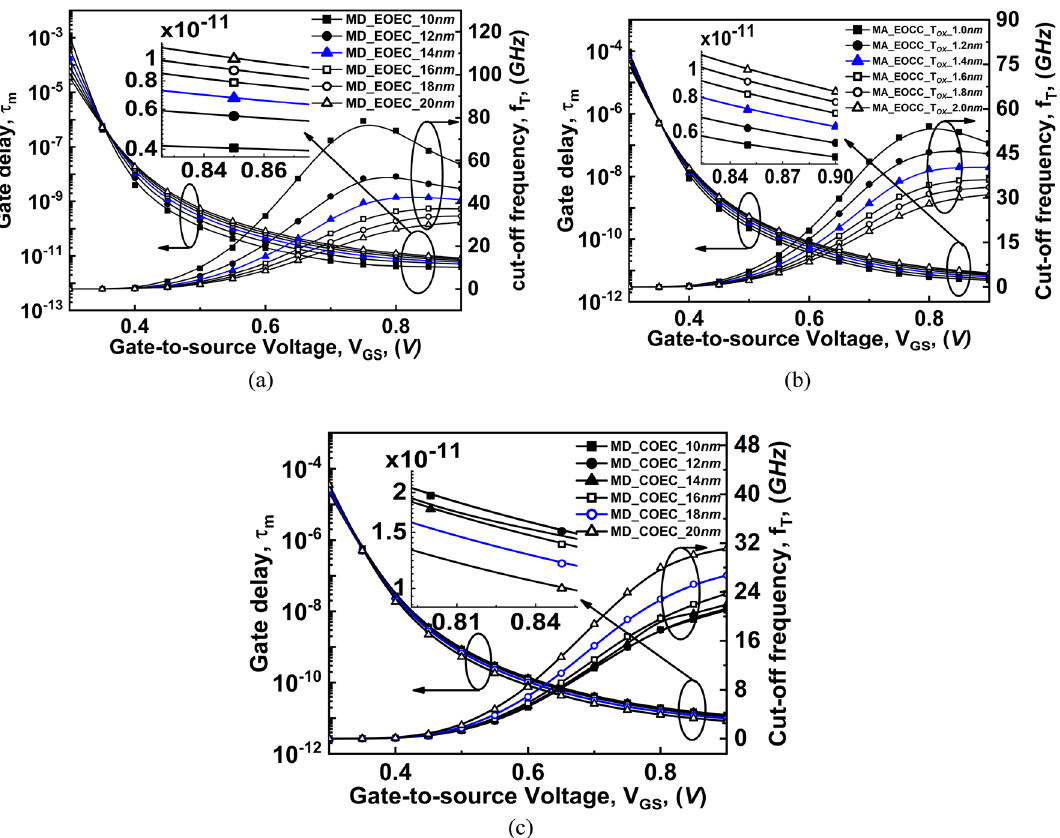
Figure 16. Comparison of variation of cut-off frequency and gate delay as a function of gate voltage at V